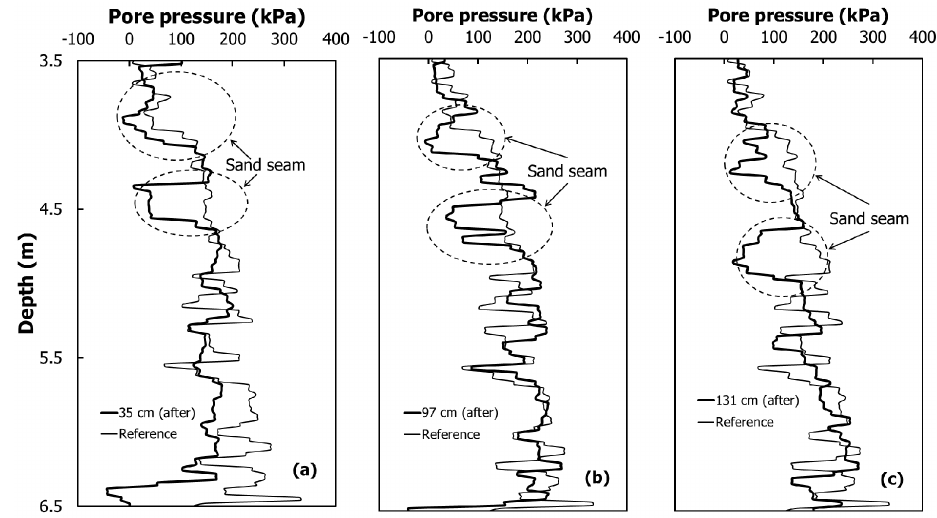
Figure 15. The variation of the pore pressure according to the horizontal distance from the electric heat pipe (Case 4), ( a ) a point 35 cm in the horizontal direction; ( b ) 97 cm; ( c ) 131 cm.